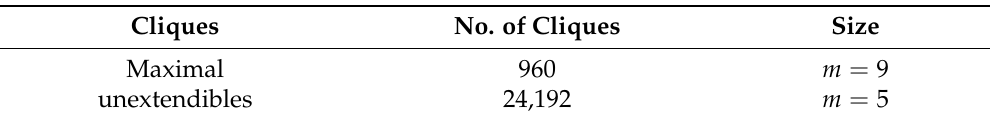
Table 2. Total number of complete sets of MUBs (maximal cliques) and the WUS (unextendible cliques) existing in 3